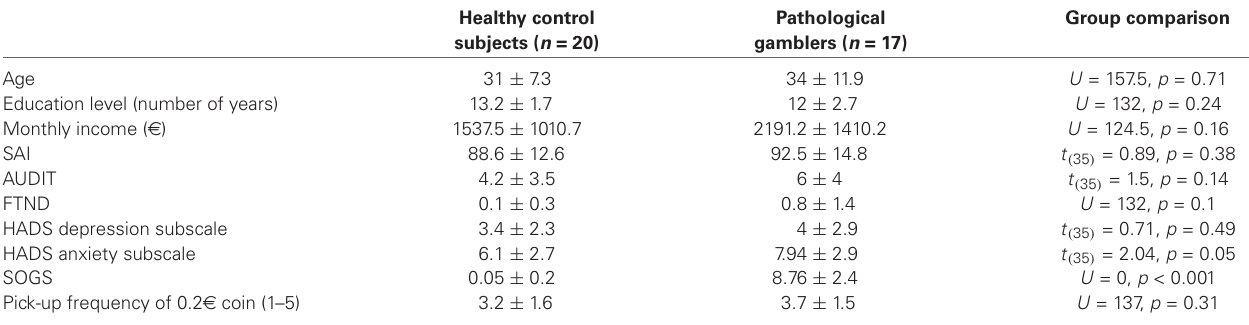
Table 1 | Demographic and clinical characteristics of PGs and healthy controls